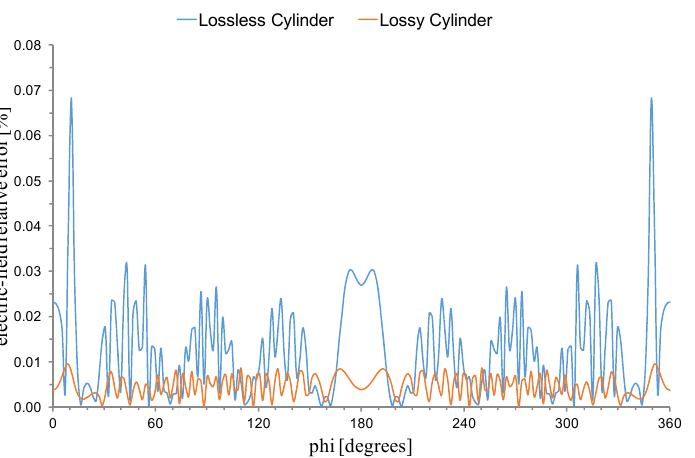
Figure 2. Relative difference in the electric-field magnitude obtained from MAS and the respective analytical solution, as a function of the observation angle in the azimuth plane, for an isolated dielectric cylinder without and with losses (comprising a trivial lattice). The parameters pertaining to the cylinder and the incident field are provided in Table 1.